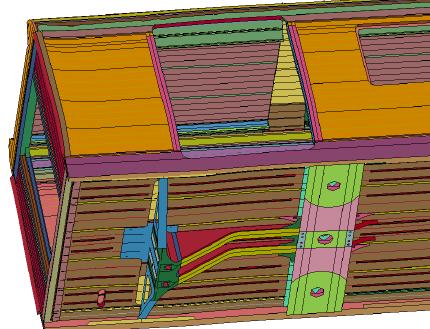
Figure 16. Deformation at the end of the collision